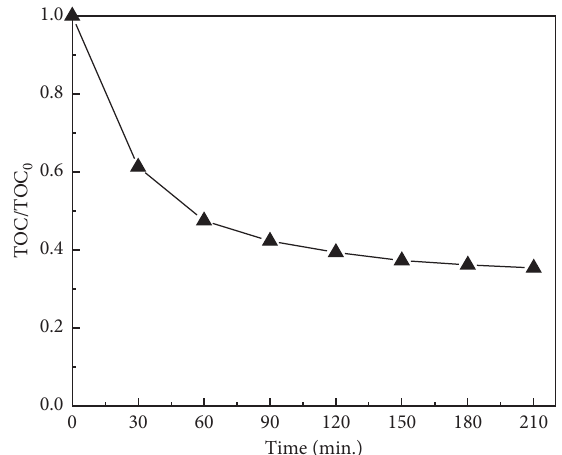
Figure 9: Mineralization efficiency of MO by